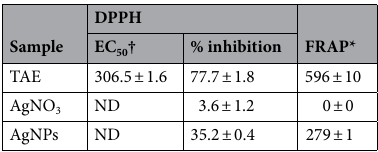
Table 1. Antioxidant activities of TAE, AgNO 3 and AgNPs. *μmol TE/g LE; †µg LE/mL, ND not determined.